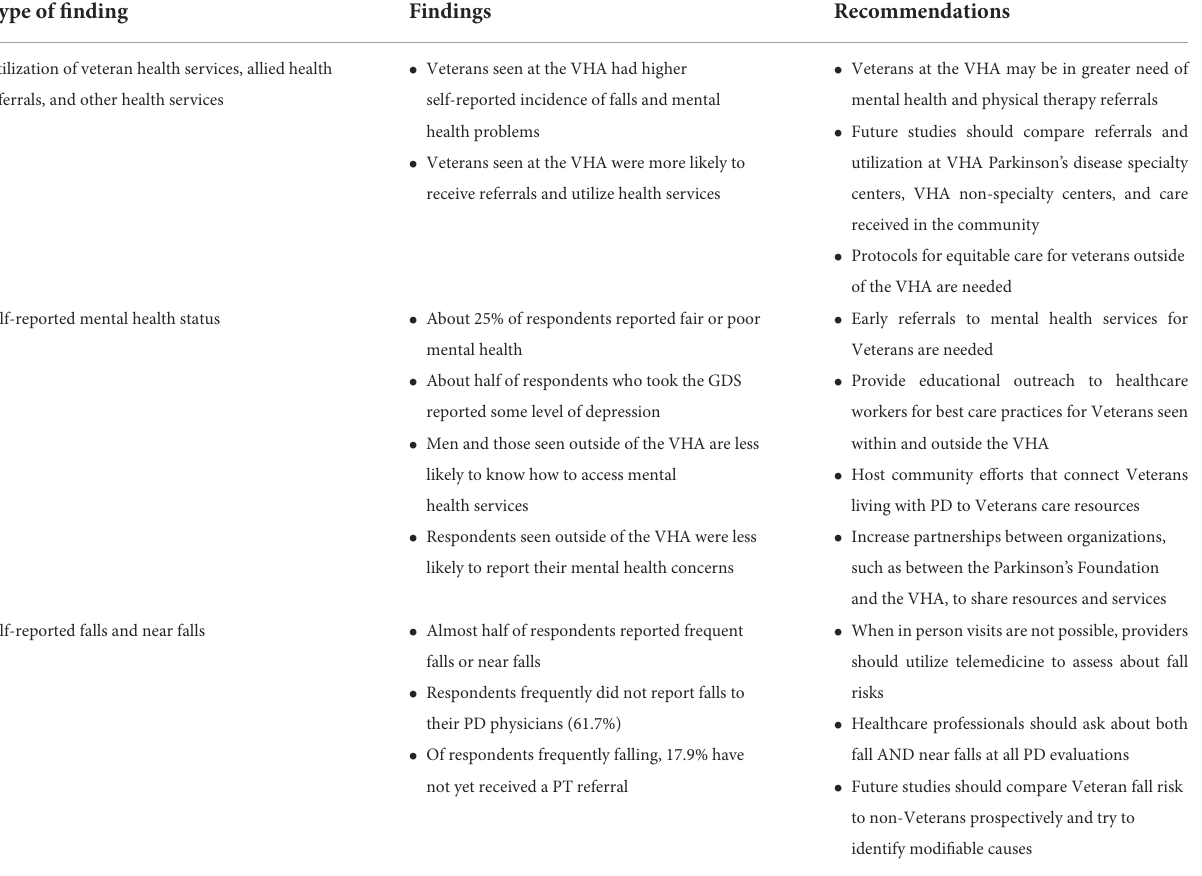
TABLE 5 Recommendations for improving health utilization and outcomes of